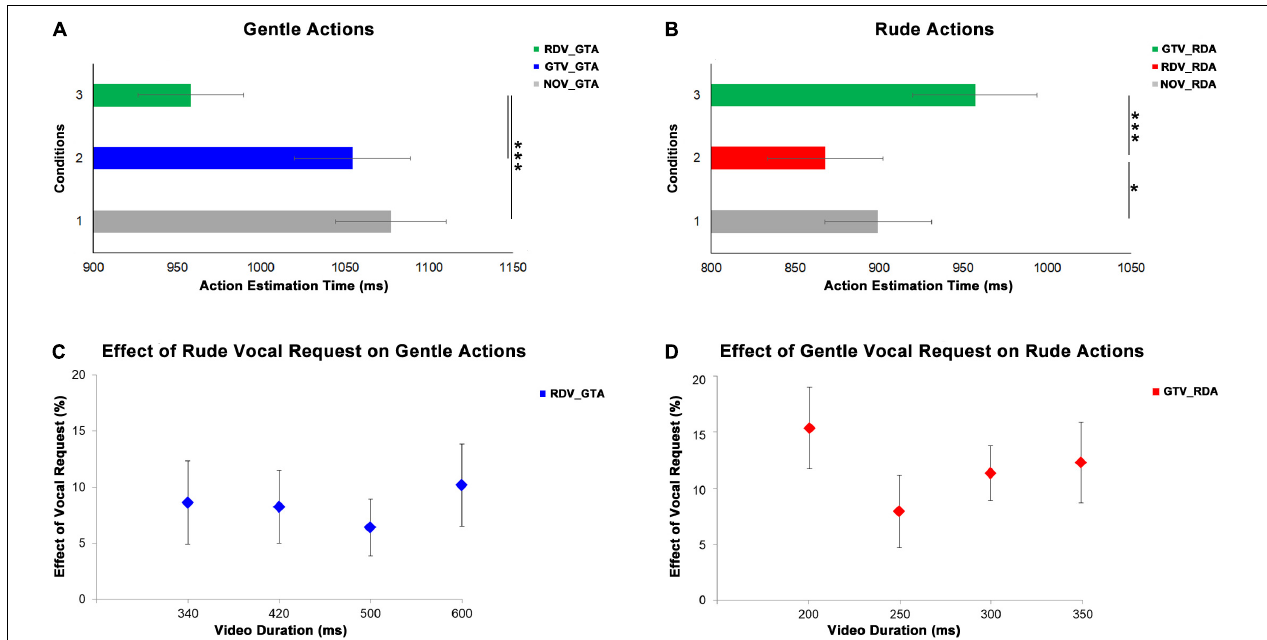
FIGURE 4 | At the top, graphs show the results obtained from the analysis of gentle (A) and rude (B) actions estimation. Gray bars refer to the baseline condition (no vocal request: NOV). Green bars refer to incongruent conditions: rude vocal request and gentle action (RDV_GTA) in panel (A) , gentle vocal request and rude action (GTV_RDA) in panel (B) . Blue bars in panel (A) refer to gentle congruent condition: gentle vocal request and gentle action (GTV_GTA). Red bars in panel (B) refer to rude congruent condition: rude vocal request and rude action (RDV_RDA). At the bottom, graphs show the effect of rude vocal requests on gentle action estimation (C) for four different durations (340, 420, 500, and 600 ms) and the effect of gentle vocal requests on rude action estimation (D) for four different durations (200, 250, 300, and 350 ms). * p < 0.05, and *** p <